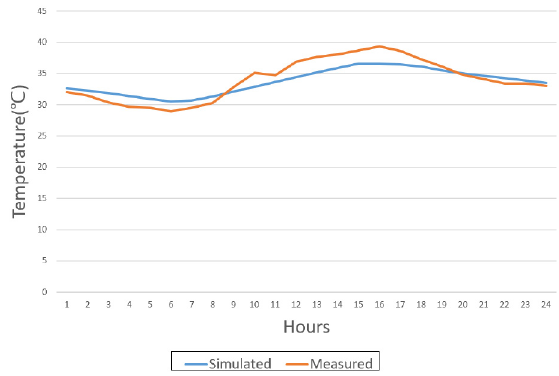
Figure 3. Comparison of simulated and